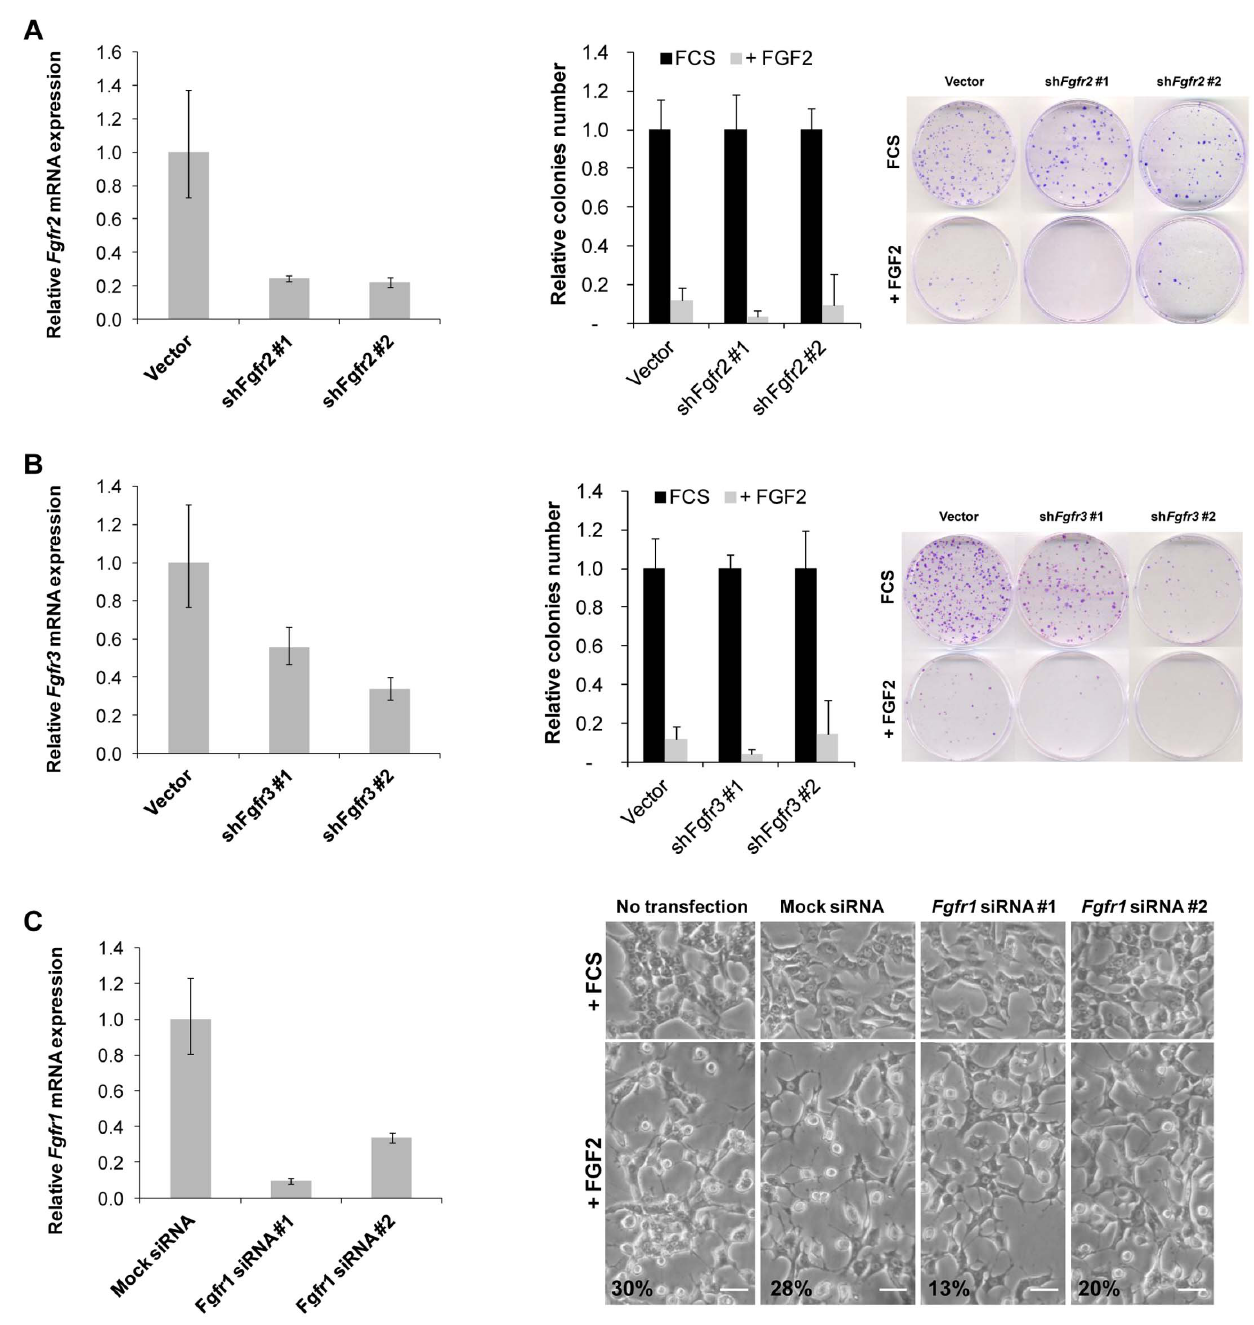
Figure 2. Knockdown of FGFR1, but not FGFR2 nor FGFR3, reduces FGF2’s cytostatic effects in Y1 cells. ( A ) Panel on the left shows the knockdown efficiency of FGFR2 in two independent sublines. Panels on the right are clonogenic assays in sublines with FGFR2 knockdown in the presence of FGF2 (10 ng/mL) for 24 h. Inset on the right shows one representative example of clonogenic assay in the indicated conditions. ( B ) Panel on the left shows the knockdown efficiency of FGFR3 in two independent sublines. Panels on the right are clonogenic assays in sublines with FGFR3 knockdown in the presence of FGF2 (10 ng/mL) for 24 h. Inset on the right shows one representative example of clonogenic assay in the indicated conditions. ( C ) Panel on the left shows the knockdown efficiency of FGFR1 by two independent siRNAs sequences. Panels on the right are representative microphotographs for morphological analysis of FGFR1 knockdown under FCS or FGF2 stimulation for 24 h. Scale bar=50 m m. Values are mean 6 s.e.m (n=3). FCS, fetal calf serum. doi:10.1371/journal.pone.0072582.g002 FGFR signaling axis concomitantly triggers two antagonistic (Figure 3B, lower panel). Furthermore, FGF2 coherently inhibited the DNA synthesis stimulated by serum only when added within pathways: first, the canonical ERK mitogenic pathway the first five hours of serum stimulation (Figure 3B, upper panel). (Figure 3A) and, second, a parallel unsuspected novel anti- Altogether these results suggest that, in early G1 phase, the FGF2/ proliferative pathway, which cause a late inhibition of serum